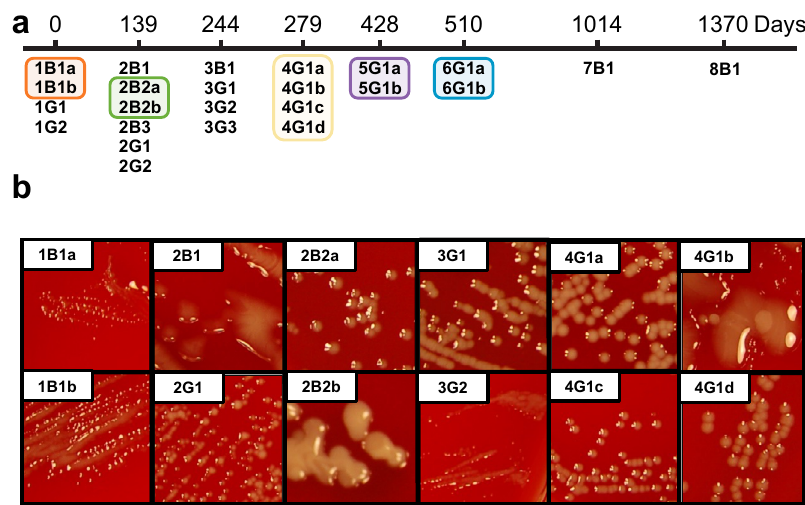
Fig. 1 Cultured B. hinzii isolates demonstrate remarkable phenotypic diversity. a Timeline of isolate collection. Isolates were named using the following rules: Sequential clinical culture number (1 – 8); followed by culture source (B blood, G gastrointestinal); followed by single colony number from the source culture (1 – 3); followed by a letter designating individual morphotypes separated from the single mixed-morphotype colony (a – d). Isolates separated from mixed-morphotype colonies are highlighted by different colors, which is maintained in Fig. 2 for ease of comparison. b Examples of the diversity of morphologies observed, which included medium-to-large-sized discrete colonies (3G1, 4G1a) and mucoid pools that ranged from translucent (2B1) to opaque